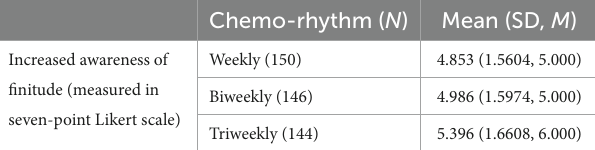
TABLE 3 Chemo-rhythm and